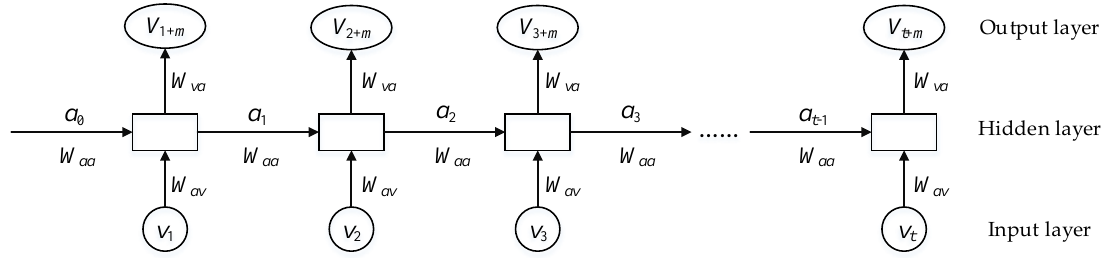
Figure 1. The structure of the RNN forecasting model for wind speed series .